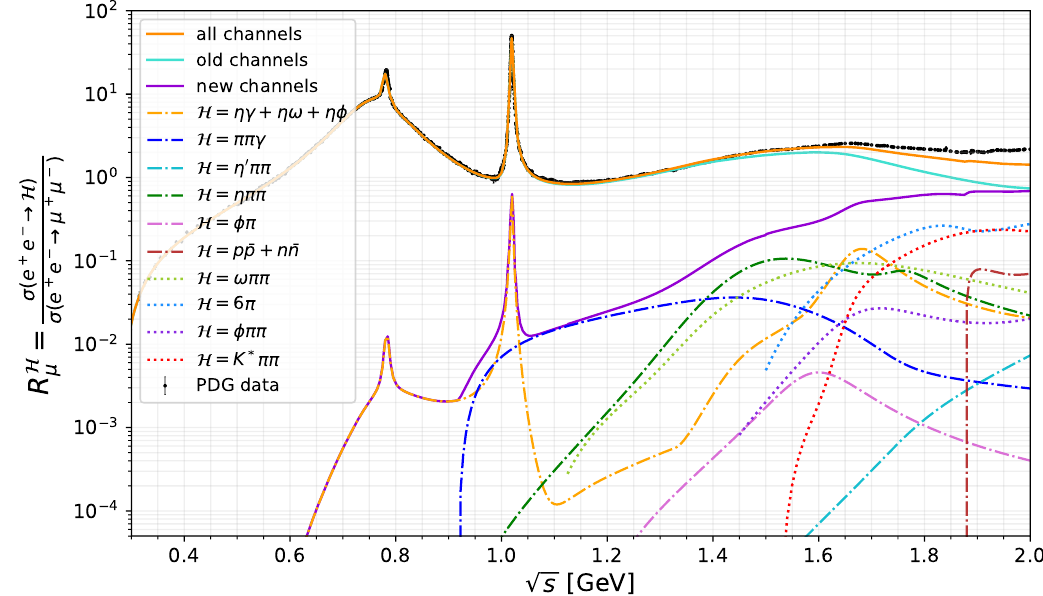
Figure 2 . Same as figure 1 but for the new channels included in this work. The dot-dashed lines indicate the hadronic channels already considered in [3] (but not in [13]), while the dotted lines indicate channels we have fitted and included here for the first time. The solid lines indicate the total R H (summed over all hadronic final states) considering: only the channels shown in figure 1 µ (cyan), only the new channels on table 3 (purple), the sum of all contributions we have calculated